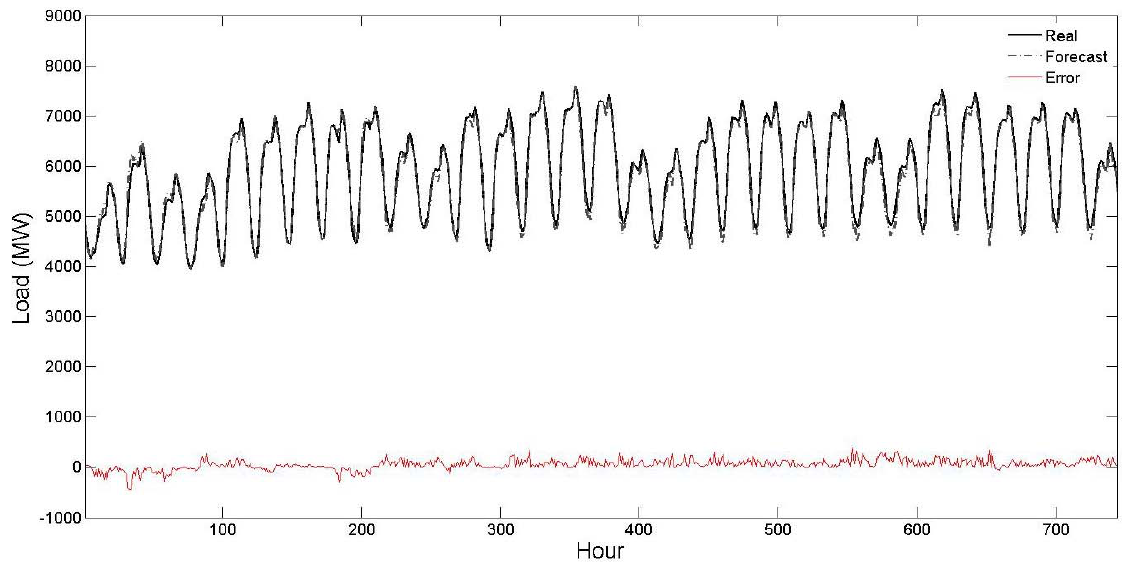
Figure 6. Curves of real values, forecast values and forecast errors for the test month of January 2004 of Table 5 (the forecast results are related to the proposed